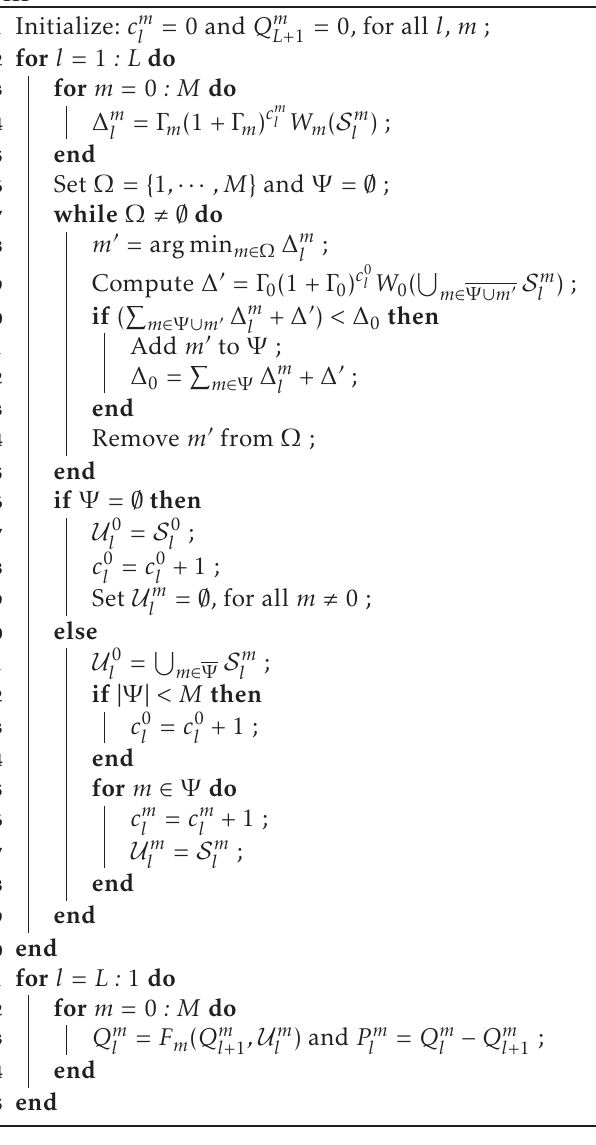
Algorithm 3: Power Allocation Algorithm for Case